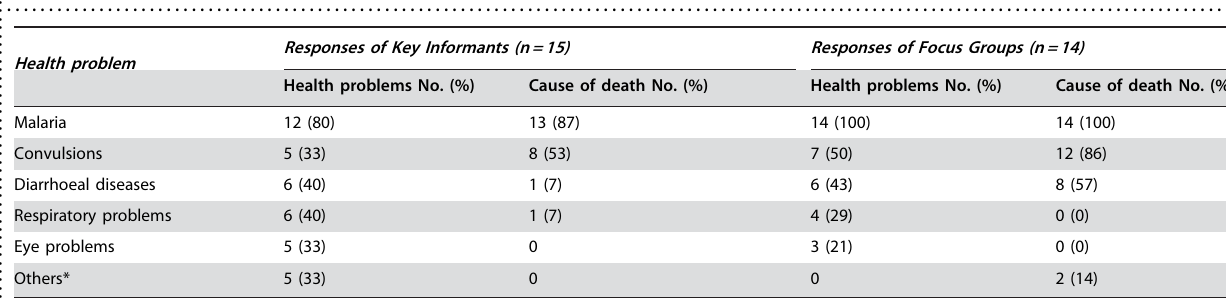
Table 2. Key Informants’ and Focus Groups’ report on main health problems and leading cause of death in children in the